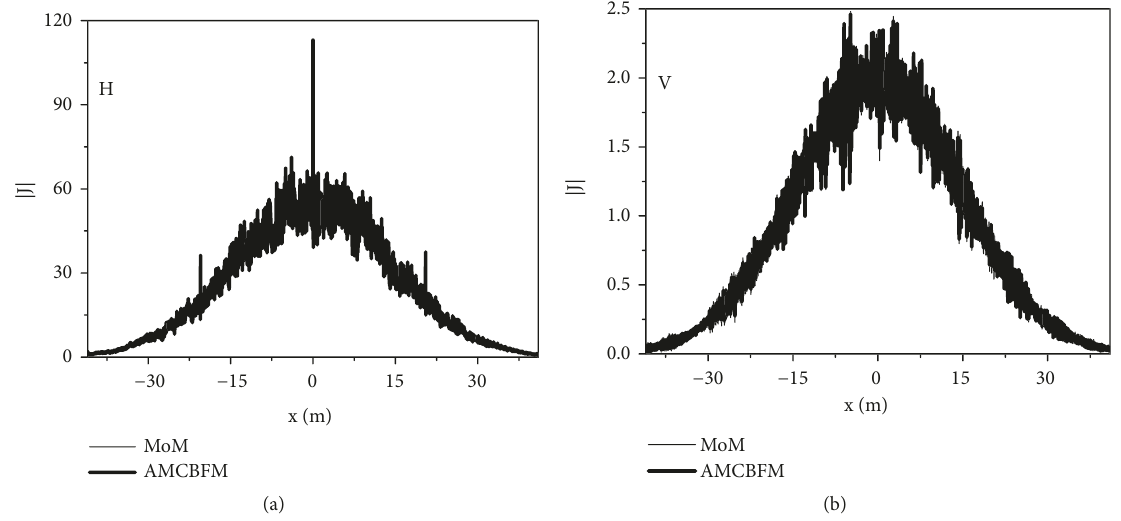
Figure 3: The currents obtained by the AMCBFM and the CBFM. (a) H polarization and (b) V